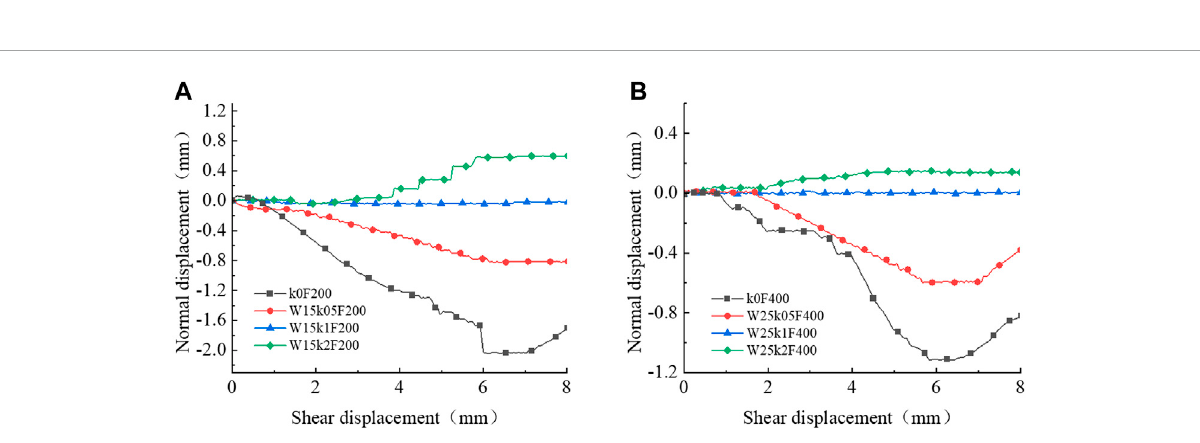
FIGURE 11 Normal – shear displacement curve under different fi lling degrees: (A) W = 15%, F = 200kPa; (B) W = 25%, F =